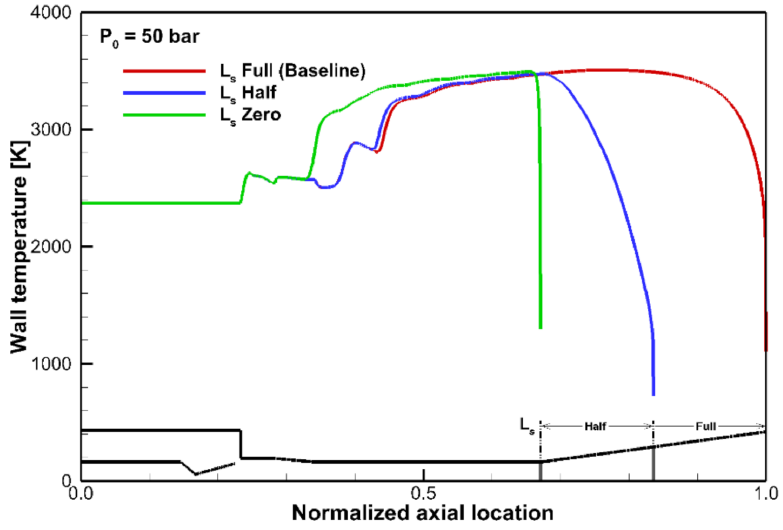
Figure 13. Wall temperatures with various diverging section length